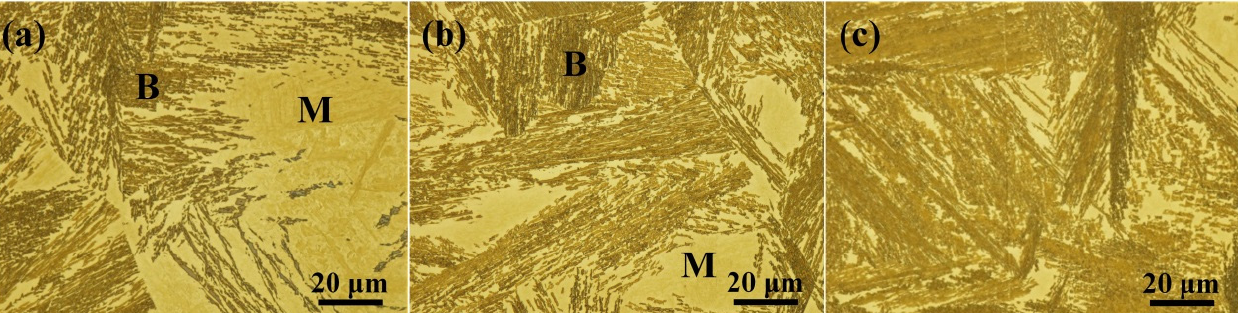
Figure 1. SEM micrographs of ( a ) IT698, ( b ) IT673 and ( c ) IT623.